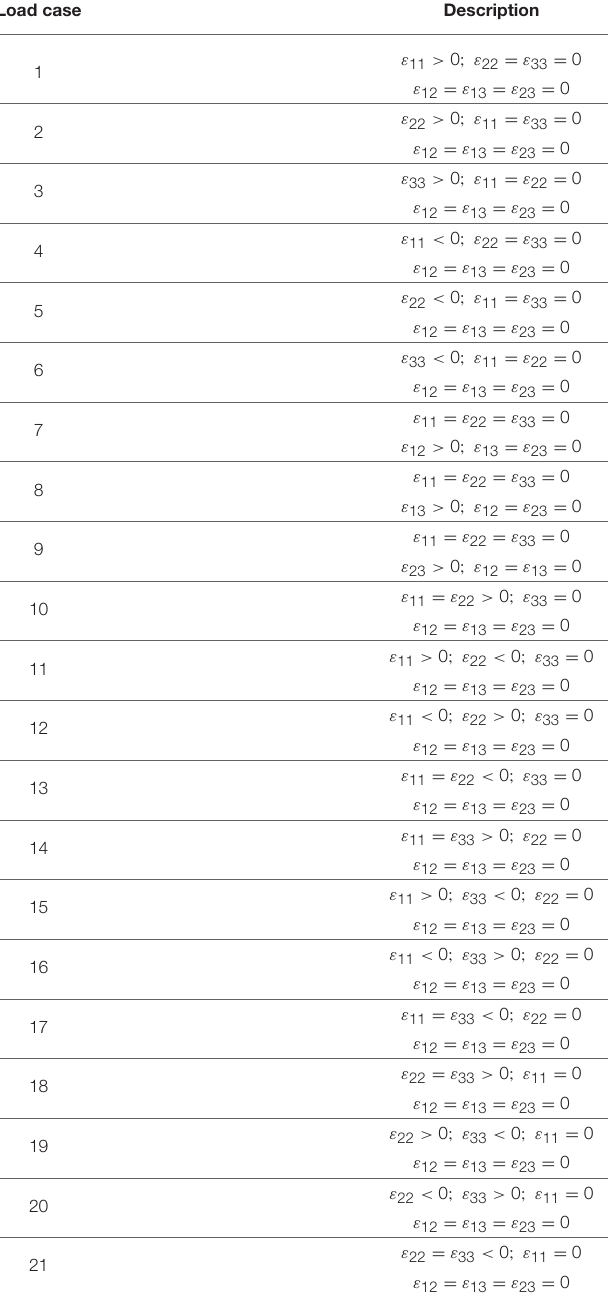
TABLE 1 | Description of the performed strain-controlled load